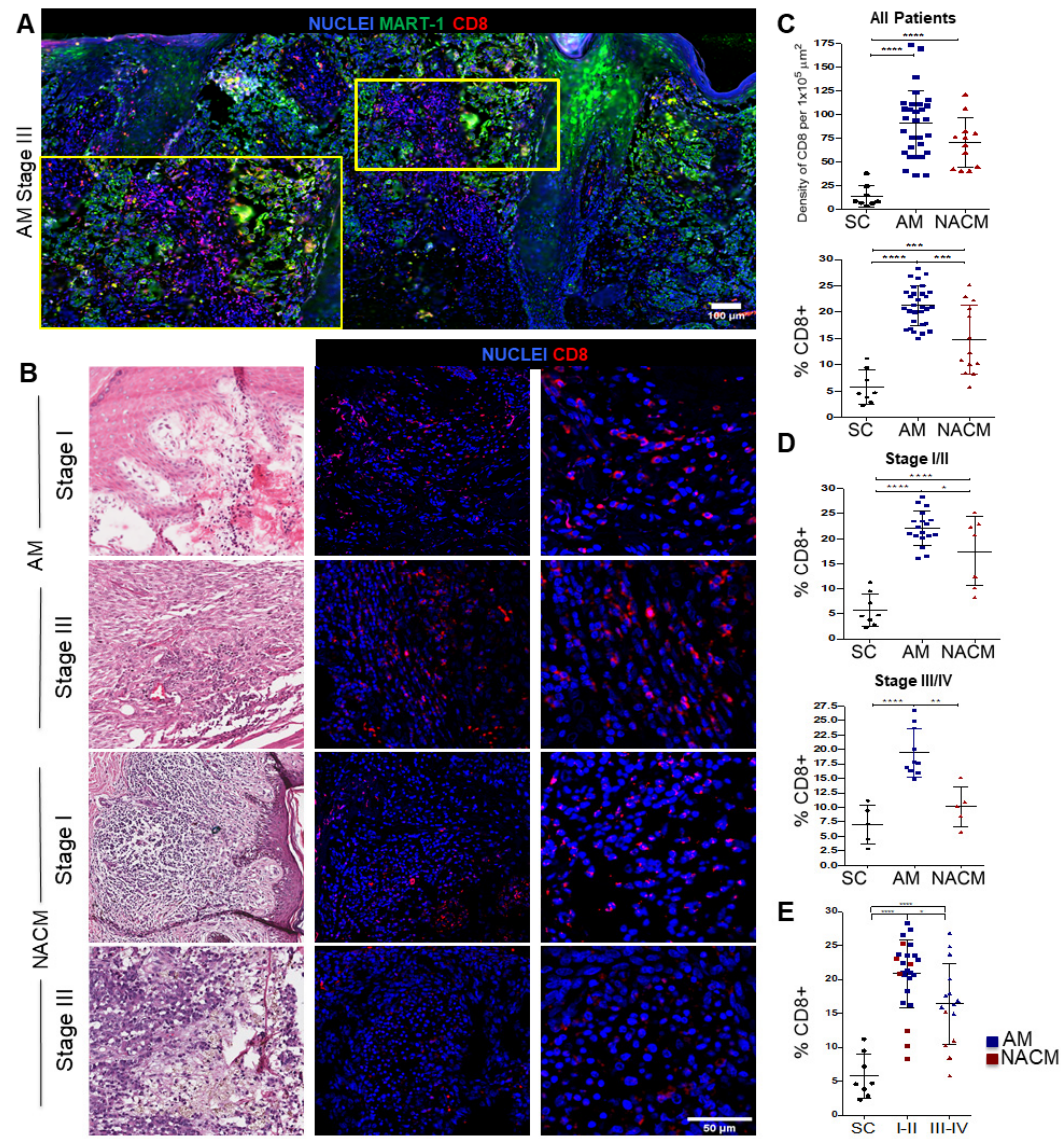
Figure 3. Assessment of the melanoma infiltrating CD8 T cells. ( A ) Whole slide scanning of a representative advanced stage III acral melanoma (AM) showing the global distribution of CD8 T cells (red) near the MART1+ tumor cells (green). Digital zoom is also presented for a better appreciation (yellow panel). ( B ) Representative hematoxylin & eosin (left column) and immunofluorescence (IF) (middle and right columns) images of stage I and III AM and non-acral cutaneous melanoma (NACM). The third column represents a digital zoom of a highly infiltrated area. Samples were stained for CD8 (red) and nuclei (blue). ( C , D ) Plots with the following comparisons between AM and NACM, ( C ) the absolute numbers of CD8 T cells per 1 × 10 5 µ m 2 (top) and percentages (bottom); ( D ) early stages I and II (top) and advanced stages III and IV (bottom). ( E ) Plot comparing the percentage of CD8 T cells between early and advanced stages. The percentage of CD8 T cells was estimated among all nucleated cells in the highly infiltrated areas selected. Supplementary Figure S2 shows the autofluorescence control for this experiment. For this analysis, we used 38 samples from the original IMSS cohort plus five advanced stage NACM samples obtained from other hospitals: AM (blue, n = 30) and NACM (red, n = 13). Healthy skin control (SC) samples were obtained from surgical resections unrelated to cancer (black; n = 8). Statistical analysis: One-Way ANOVA’s test with Tukey’s post hoc test for multiple comparisons. * p < 0.05, ** p < 0.01 *** p < 0.001, and **** p <